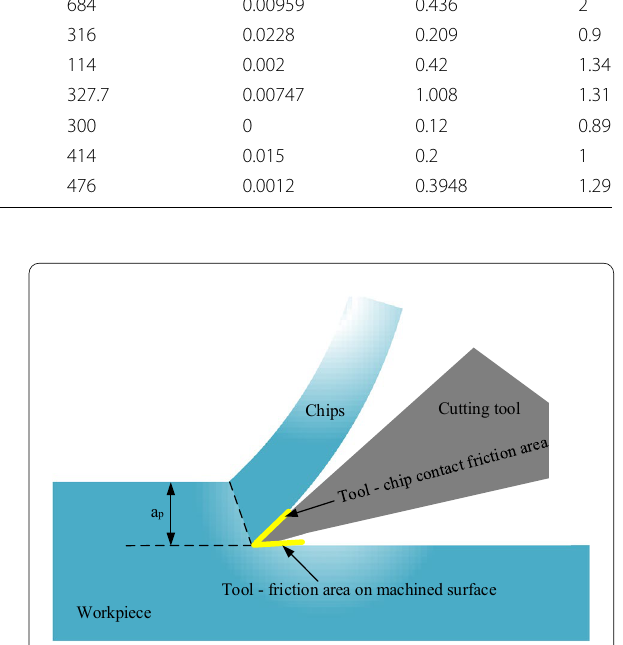
Figure 8 Schematic of friction area in cutting process